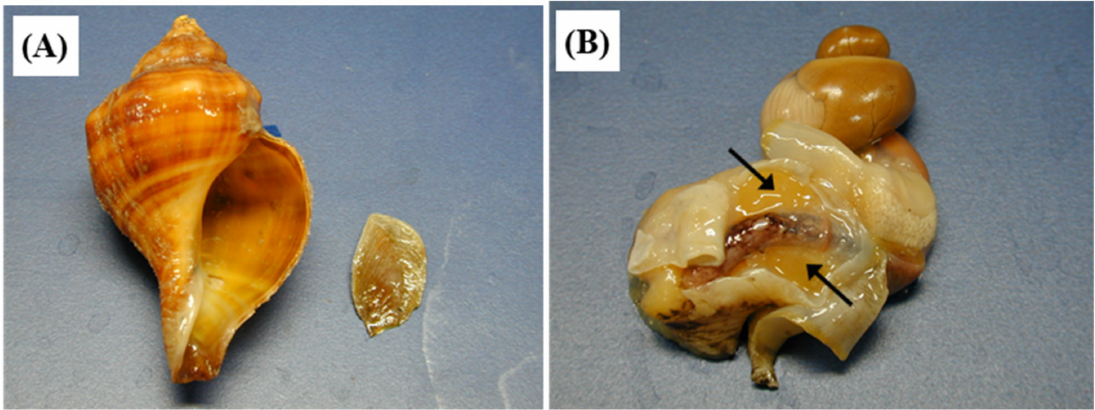
Figure 1. Pictures of the shell and operculum ( A ) and soft tissue ( B ) of Neptunea arthritica . Note that in ( B ), the mantle has been cut open to indicate the location (shown by arrows) of the salivary